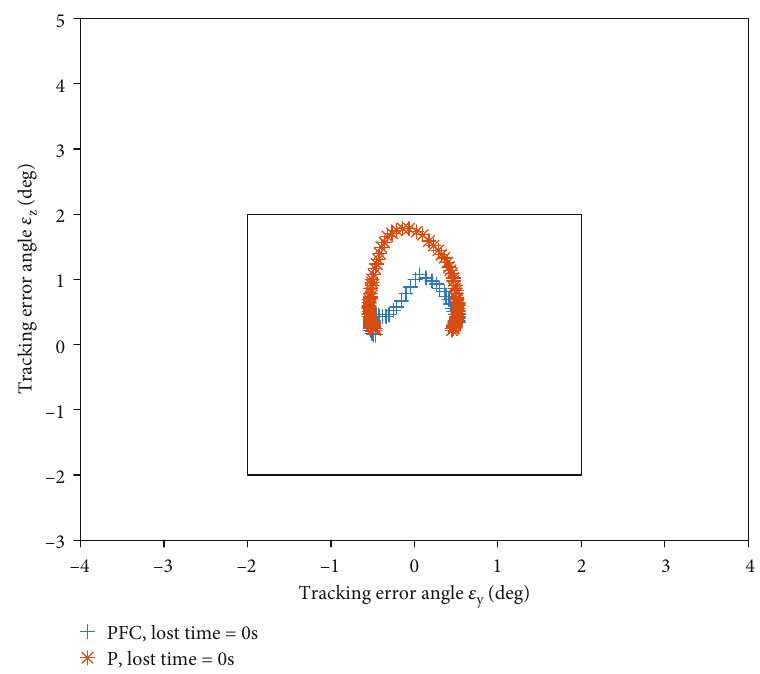
Figure 8: Tracking errors of PFC and PI (5 deg, 30deg/s).